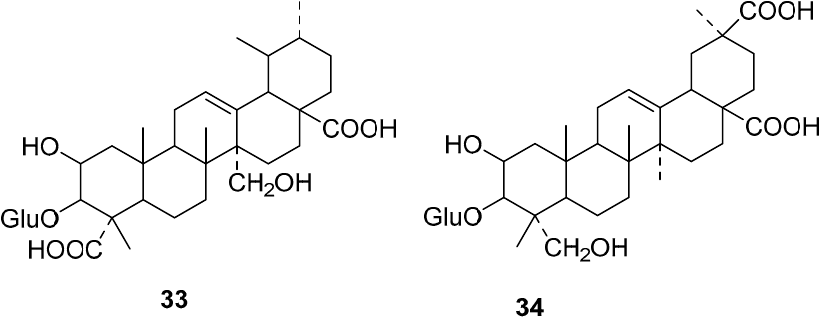
Figure 5. Compounds identified by LC / MS on a Chinese specimen of Phytolacca americana [41]. Esculentoside isomer 33 and esculentoside P 34 .